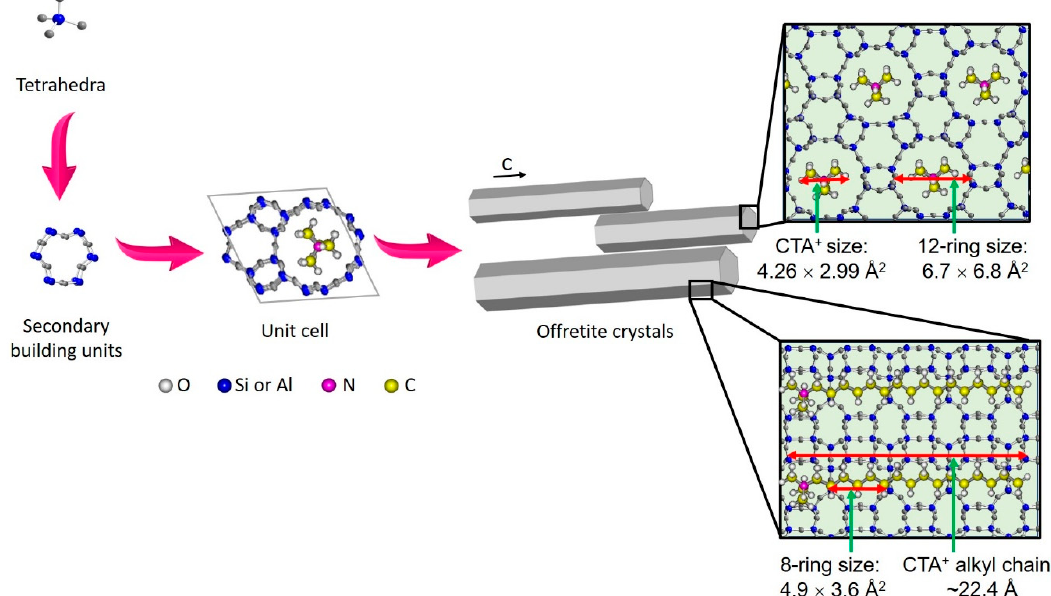
Figure 4. Formation mechanism of offretite zeolite templated by CTA + cations (K + cations are not shown for simplicity).